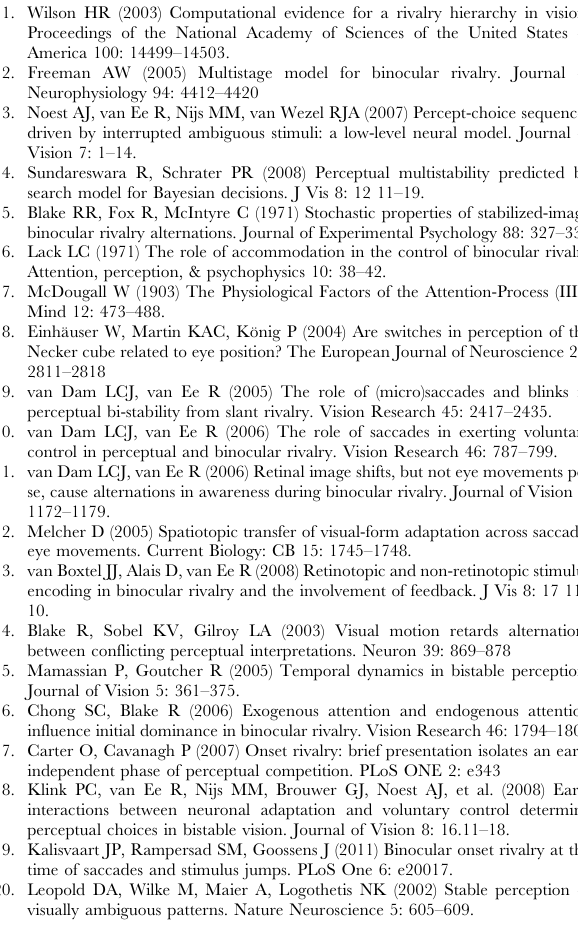
Figure S2 Covariograms of shifts and beeps with blinks. We considered the possibility that the observed changes in blink rate resulted indirectly from a synchronization of the blinks with large image shifts or the preceding beeps. Therefore we made covariograms of blinks and large retinal image shifts (A) and blinks and beeps (B). Top panels show the results from individual subjects. Bottom panels plot the mean 6 SEM across all four subjects. No consistent relation was found between blinks and large shifts, or between blinks and beeps.